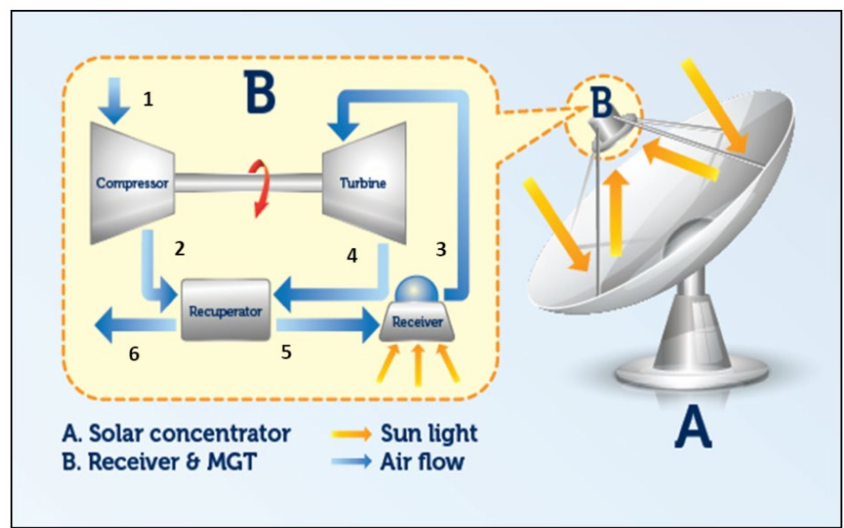
Figure 1. Scheme of the Optimised Microturbine Solar Power system (OMSoP)